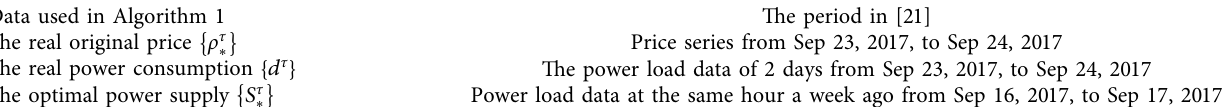
Table 2: Data used in the simulation.